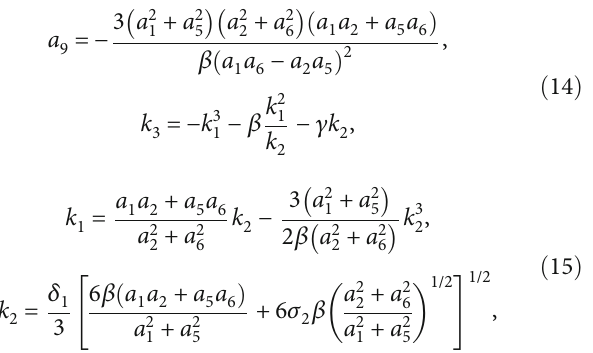
Figure 1: The rational lump solution equation (10) with a plot at t = 0 ; (b) the moving path with the contour curves of lumps at the di ff erent